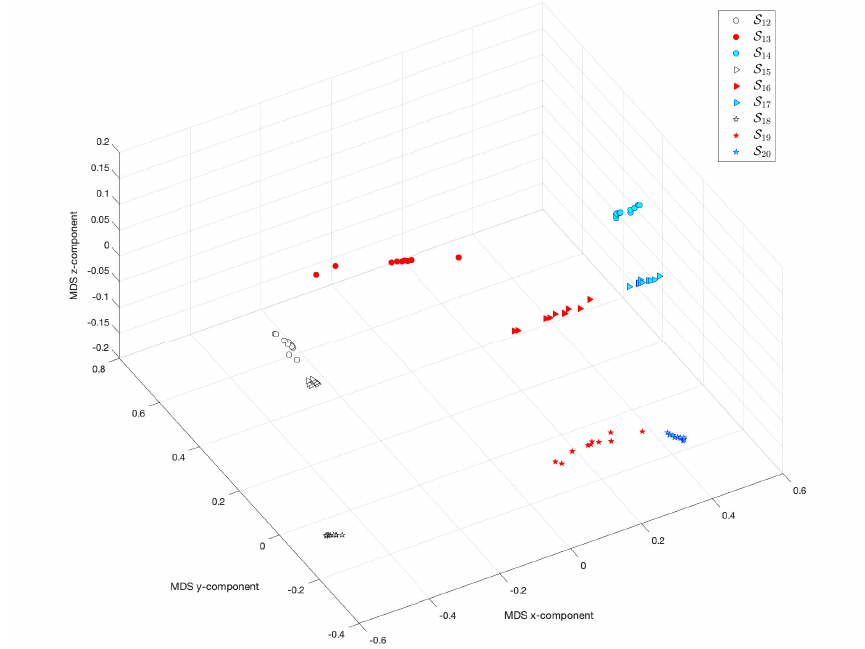
Figure 22. The 3-dimensional MDS locus, using the Lorentzian distance (6), for 10 runs of each scenario S = 12, . . . ,20, with performance captured by the cost indices I i , i